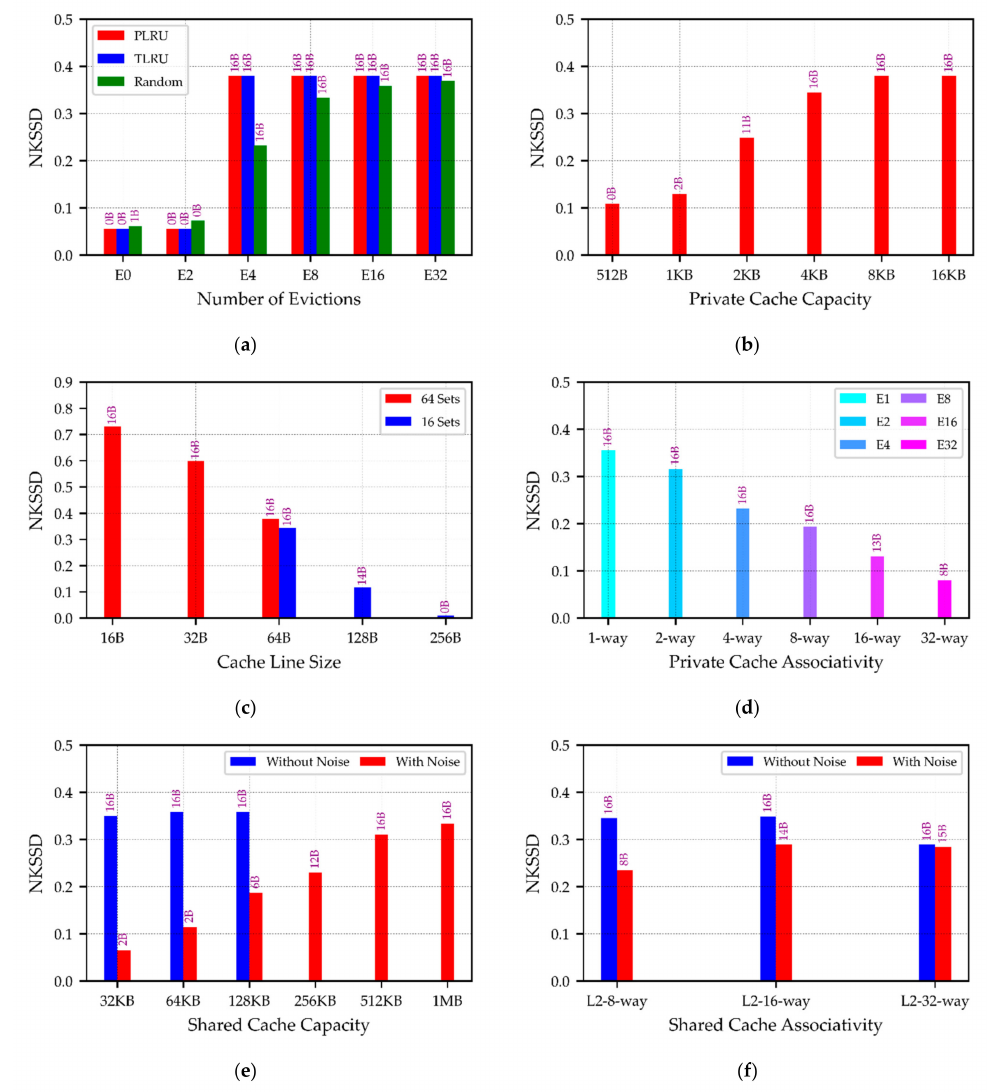
Figure 7. NKSSD in different configurations. Graphs ( a – f ) illustrate the NKSSD of private cache replacement policy, private cache capacity, cache line size, private cache associativity, shared cache capacity, and shared cache associativity in different configurations. The higher the bar, the larger the NKSSD, and the more information the cache leaks. The text above the bar indicates the number of key bytes that can be inferred after 50 attacks. In general, the larger the NKSSD, the more key bytes that can be inferred. Moreover, when all the key bytes can be cracked, the NKSSD can still be used to compare the degree of leakage of the current cache